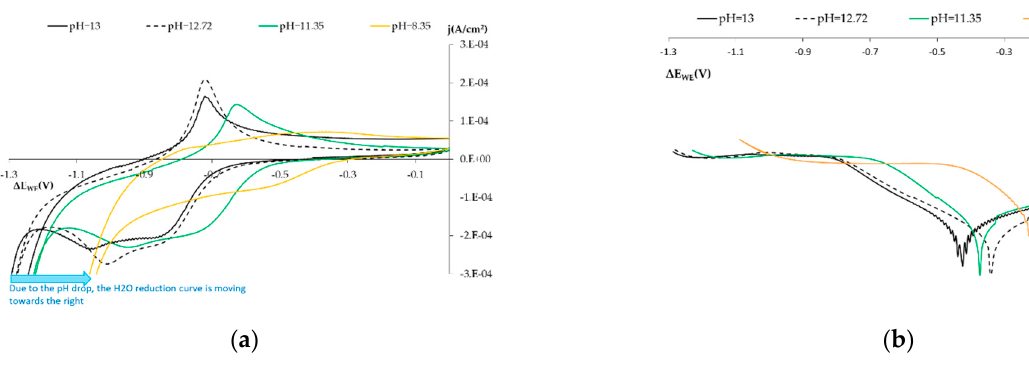
Figure 6. ( a ) Voltagrams obtained with the SS sensor at various pHs. ( b ) Voltagrams expressed logarithmically, only cathodic sweeping. Black line: 0.1 m KOH solution (pH = 13). Dashed black line: 0.1 m NaOH (pH = 12.72). Green line: 0.1 m Na 2 CO 3 solution (pH = 11.45). Orange line: 0.1 m CNaHO 3 solution (pH = 8.35).